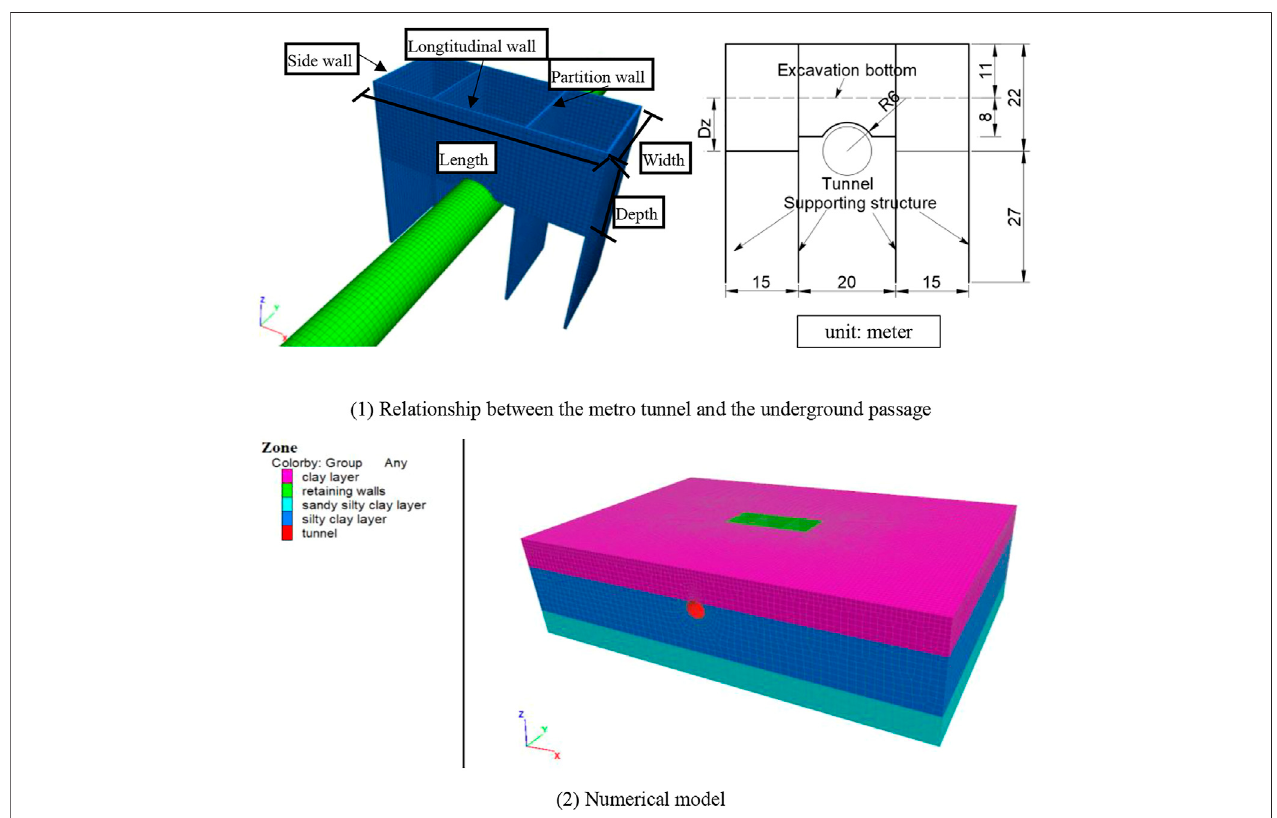
FIGURE 8 | Numerical model of the intersection engineering of Case Ⅱ